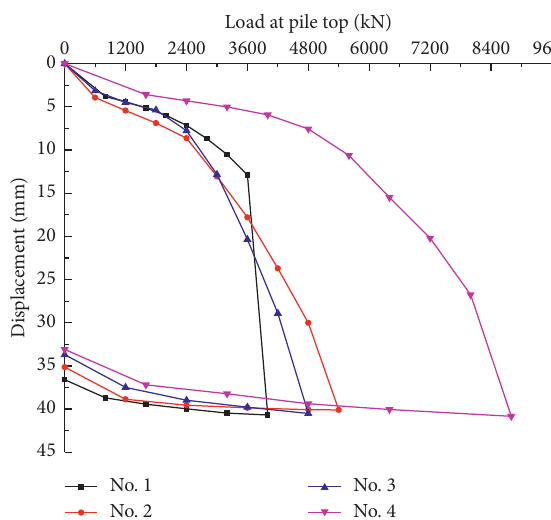
Figure 8: Load-displacement curve of static load